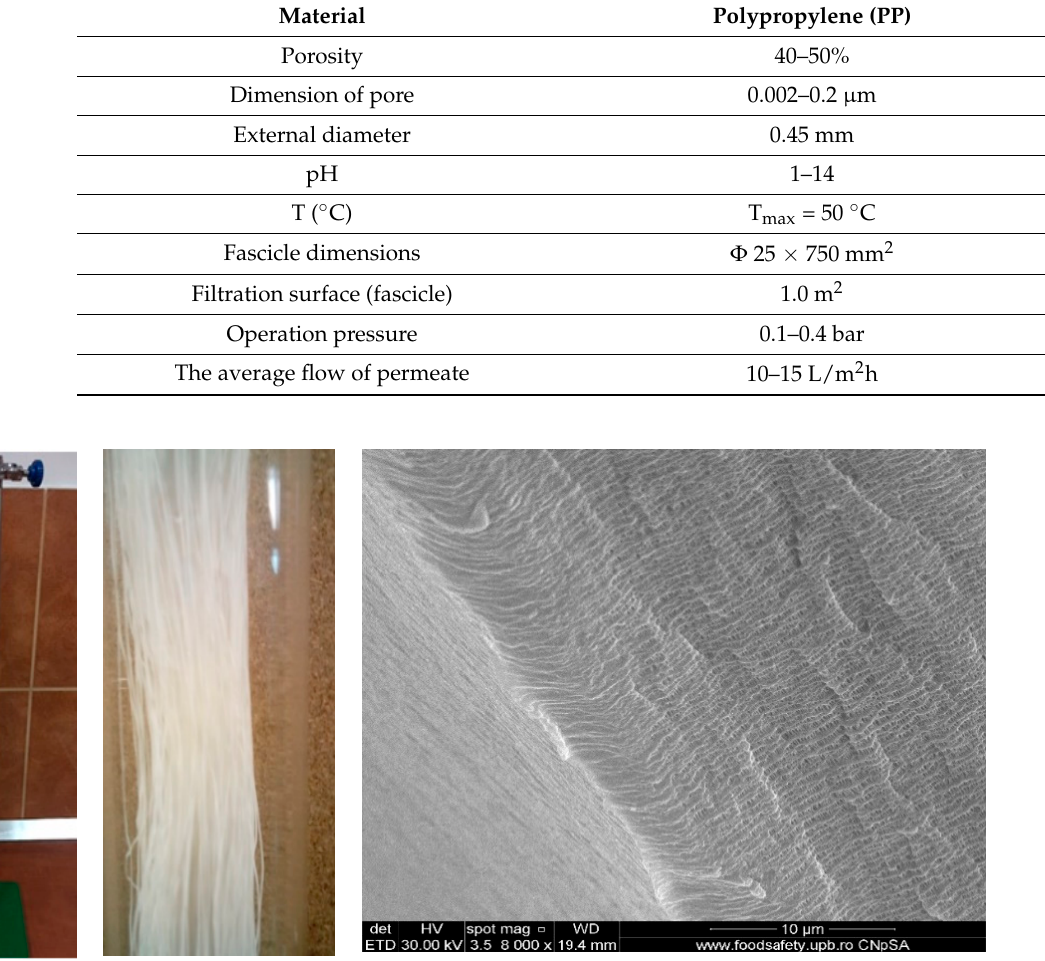
Table 1. Main features of the polypropylene fibers (GOST Ltd.).